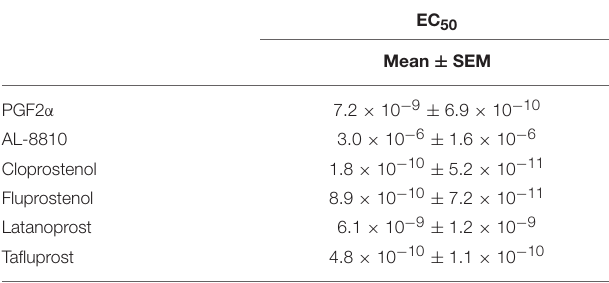
TABLE 1 | EC 50 values for β -arrestin 2-RlucII recruitment to the AT1R-Venus/FP-WT